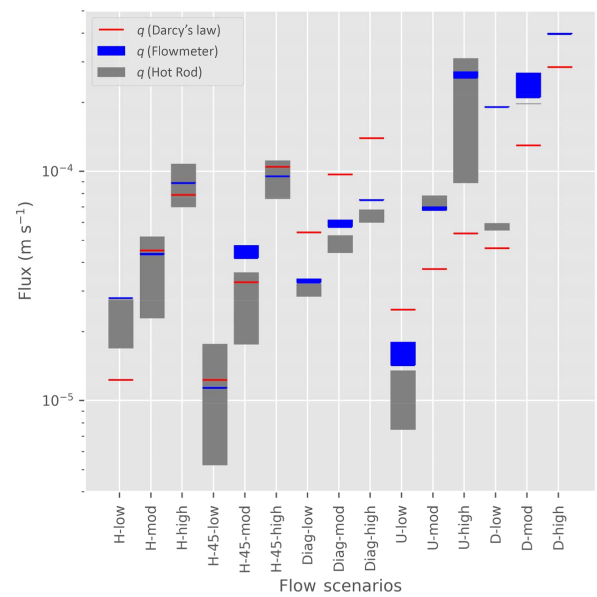
Figure 6. Fluxes of the different flow scenarios, listed along the x axis, and different flow intensities calculated based on different heat injection depths of the HPS (grey bars) compared to fluxes de- termined based on Darcy’s law (hydraulic gradient and hydraulic conductivity – red dashes) and the flux calculated from the mea- sured discharge from the tank using an ultrasonic flowmeter and the cross-sectional area of the tank (blue